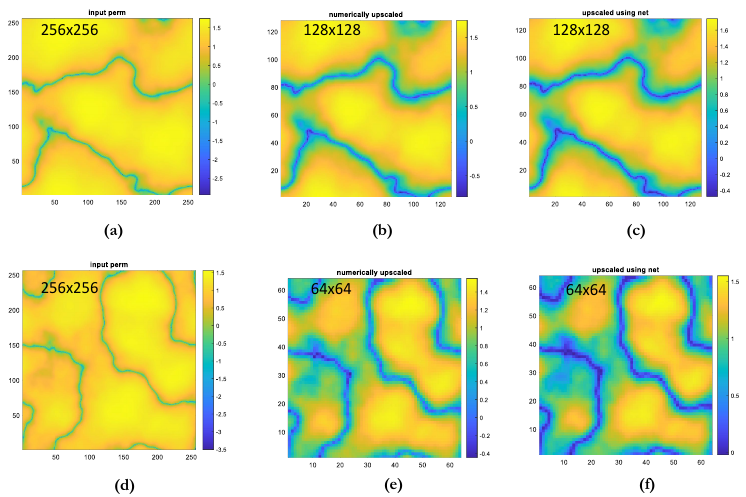
Figure 16. Figure showing successive comparison of upscaling from input permeability of 256 × 256 upscaled to 128 × 128 to 64 × 64. ( a , d ): 256 × 256 input permeability. ( b , c ): 128 × 128 input permeability. ( e , f ): 64 × 64 input